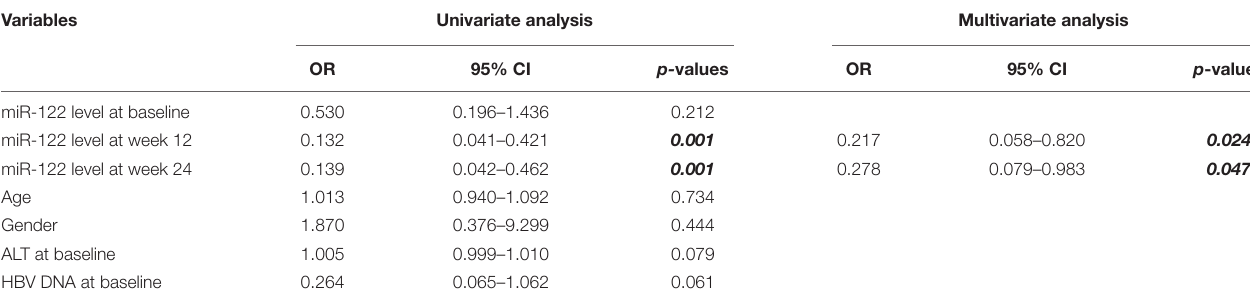
TABLE 2 | Univariate and multivariate analyses of associations between miR-122 levels and virological response at week 96. Variables Univariate analysis Multivariate